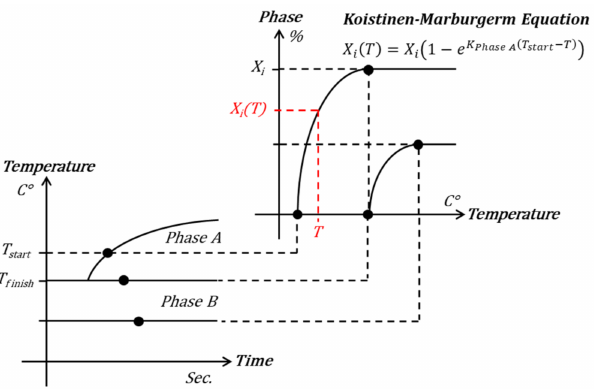
Figure 5. Phase fraction at any temperature, using the Kiustinen–Marburgerm